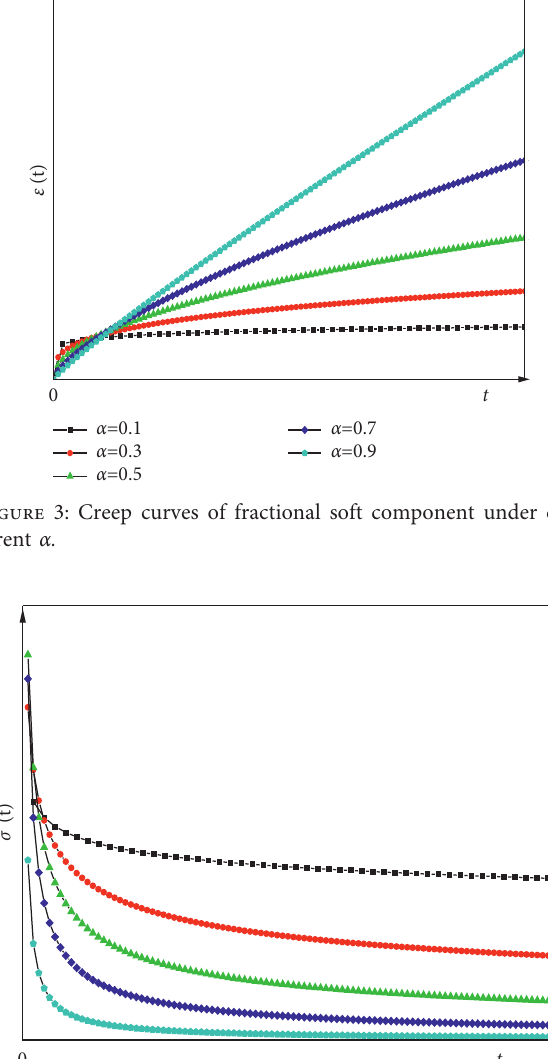
Figure 2: Fractional soft element.